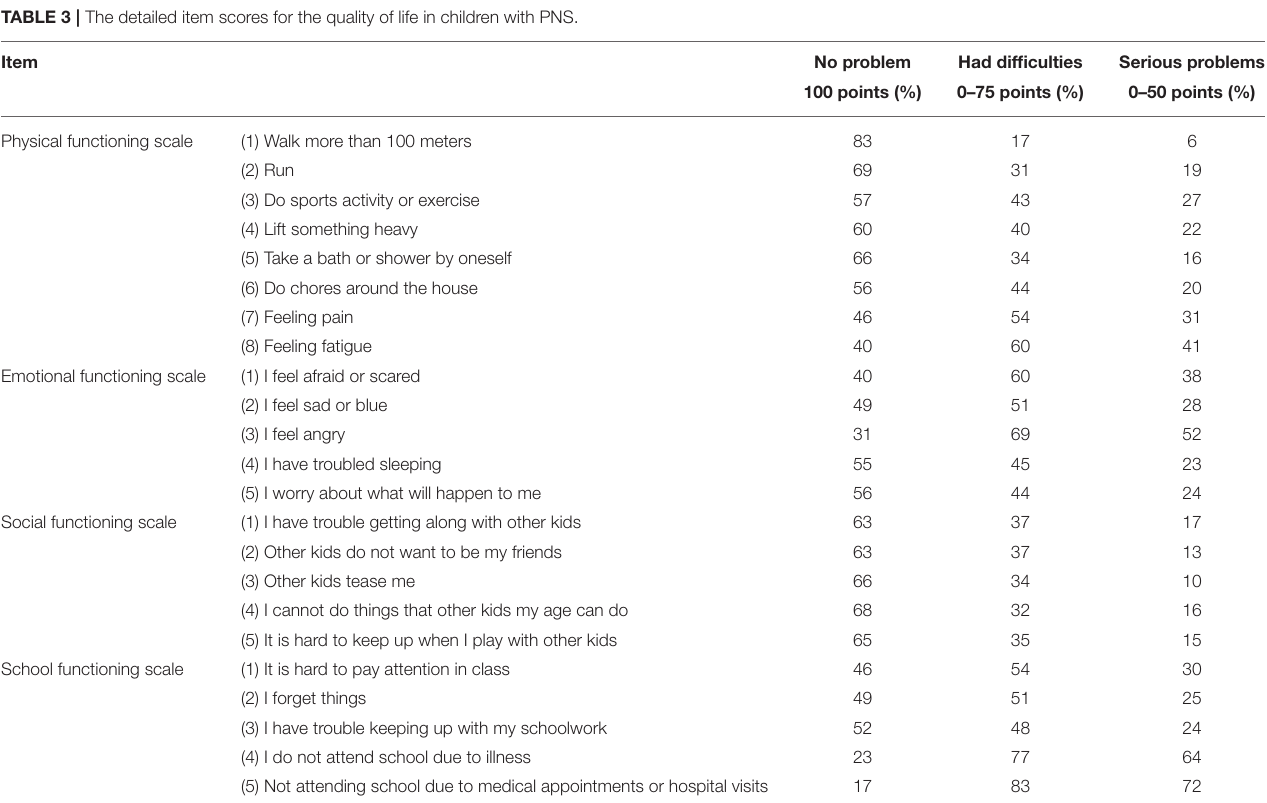
TABLE 3 | The detailed item scores for the quality of life in children with